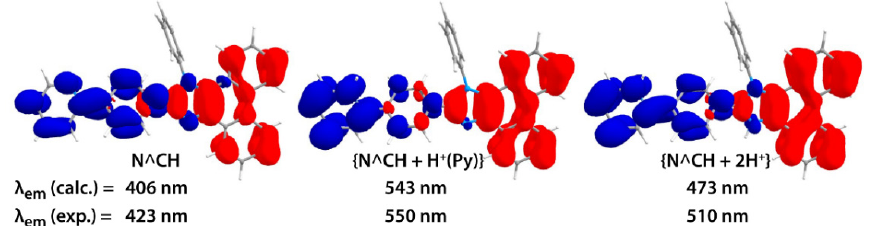
Figure 5. The decrease (blue) and increase (red) of electron density in the S 1 → S 0 electronic transitions for N^CH , {N^CH+H + (Py)} containing protonated pyridine group, {N^CH+2H + } containing proto- nated pyridine and imidazole groups; calculated and experimental emission wavelengths are given in the bottom rows.